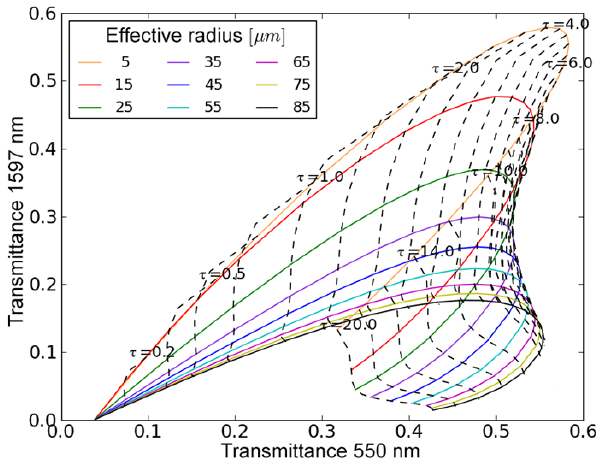
Figure 4. Example of a lookup table of transmittance at 550 and 1600nm simulated for θ 0 = 36 ◦ , θ v = 0 ◦ , φ rel = 180 ◦ and habit